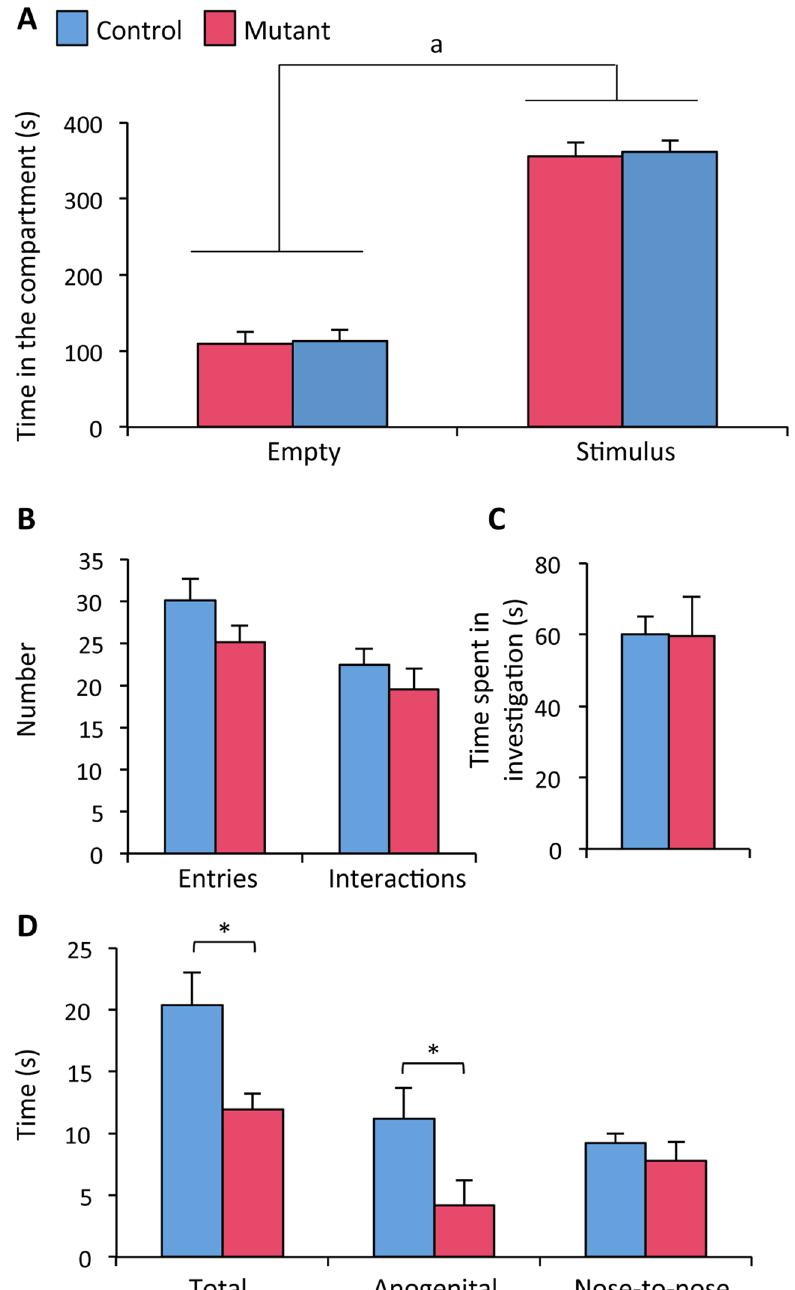
Figure 1. Sociability and social interaction in control (ER β fl/fl ) and mutant (ER β NesCre ) male mice. ( A–C ) Sociability: Time spent in the empty and stimulus compartments of the three-chamber test ( A ), number of entries and interactions in the stimulus compartment ( B ), and time spent in olfactory investigation of the stimulus ( C ). Data are expressed as means ± S.E.M (n = 12–15 males per genotype). b p < 0.0001: effect of compartment with males more interested in the stimulus compartment. ( D ) Social interaction: Time spent in total, anogenital and nose-to-nose interaction. * p < 0.05 versus the control